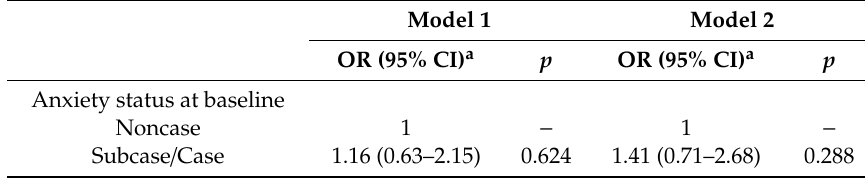
Table 2. Risk of VaD associated with anxiety using logistic